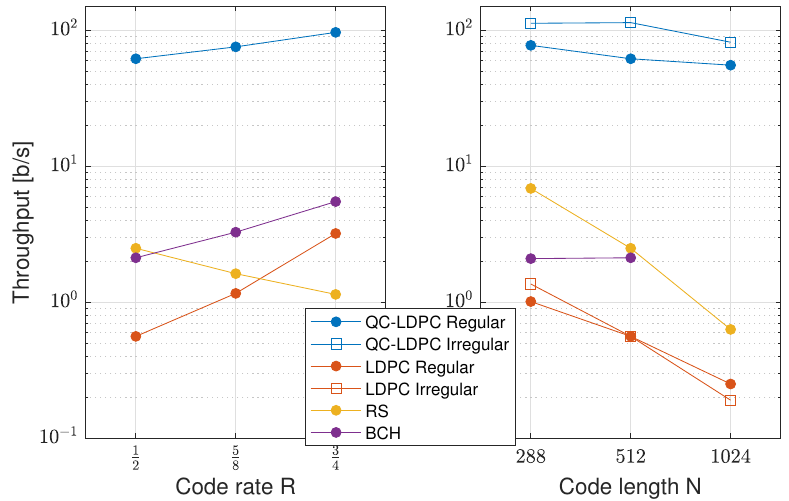
Figure 9. Throughput of the encoders vs. code parameters.